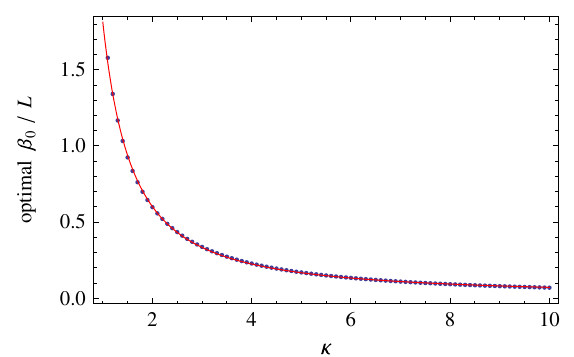
FIG. 12. The optimal bending profile parameter r =(cid:5) (cid:5) as a function of (cid:12) for minimum EME emittance. The max 0 red curve is given by the approximate expression r (cid:1) 5 : 03 þ 6 : 37 (cid:12) þ 0 : 103 (cid:12) 2 þ 0 : 004 26 (cid:12) 3 (cid:1) 0 : 000 389 (cid:12) 4 .